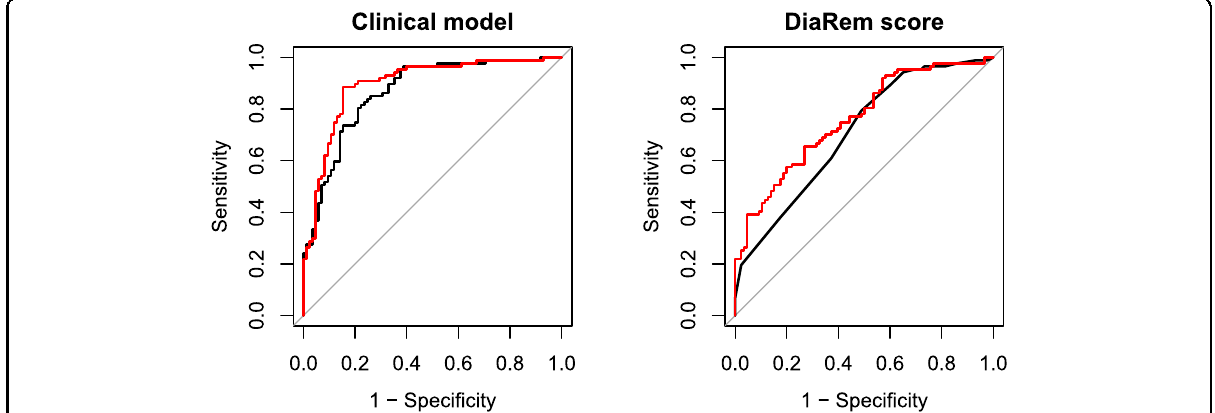
Fig. 2 Receiver operating characteristic (ROC) curves for clinical models alone (black) or with signi fi cant metabolite factors (red). Factor 14 (betaine and choline) and factor 2 (BCAA, tyrosine, phenylalanine, methionine, arginine and histidine). On the left, the black line shows the ROC curve for a clinical model including baseline HbA1c level, insulin use, number of non-insulin type 2 diabetes medications, and weight change 2 years post- intervention. On the right, the black line shows the ROC curve for the DiaRem